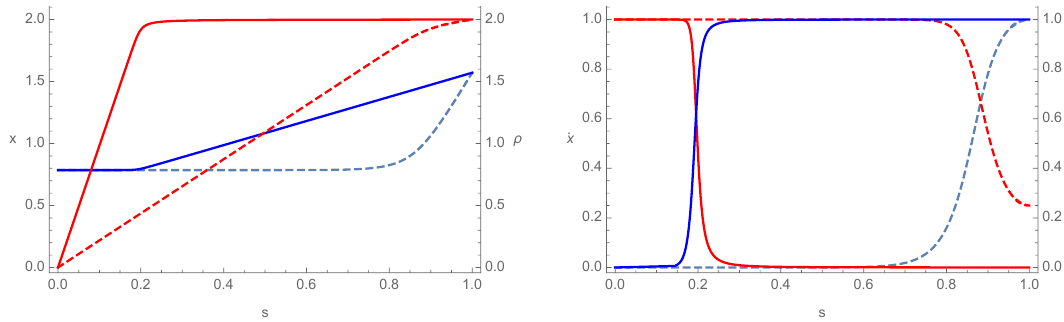
Figure 5 . (Left:) Plot of x ( s ) (blue) and (cid:26) ( s ) (red) for the parameter values set by (F.17) and (F.18), with (cid:15) = 10 (cid:0) 16 . (Right:) Plot of _ x ( s ) (blue) and _ (cid:26) ( s ) (red) for the same. In both plots, the dashed curves correspond to a = 2, while for the solid curves we have set a = 50. One sees that the amount of \time" for which the circuit remains on the constant x = (cid:25)= 4 segment is inversely proportional to the strength of the penalty factor. For illustrative purposes, we have normalized (cid:26) j s =1 to 2 in the left plot, and normalized both _ x j s =1 and _ (cid:26) j s =1 to 1 in the